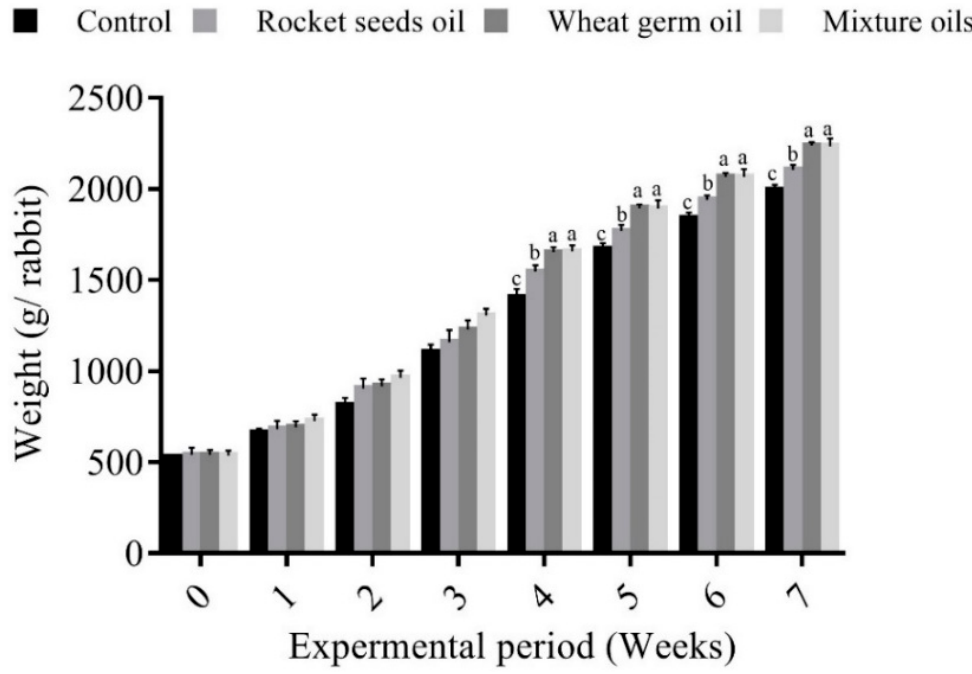
Figure 1. Body weight of V-line growing rabbits (5–12 weeks of age) that were administered orally with rocket seed oil, wheat germ oil, and their mixture. Columns marked with different superscripts are significantly different at p ≤ 0.05.